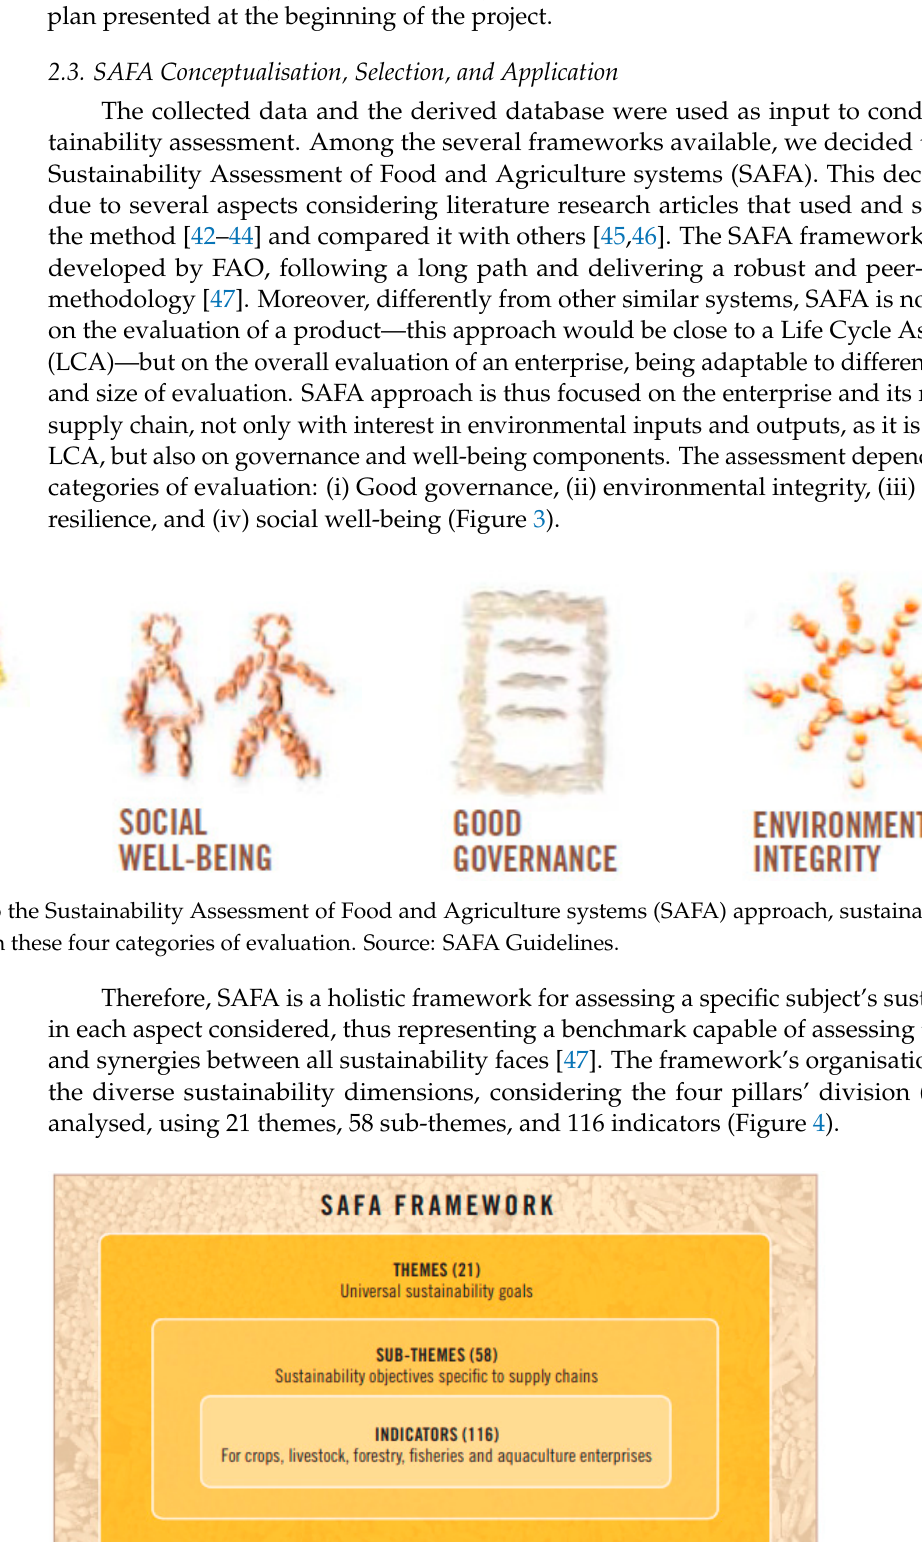
Figure 2. The sixth start ‐ up divide in fields. Two start ‐ ups (no. 1 and 3) do not directly cultivate fields, so they are not relevant on the map.